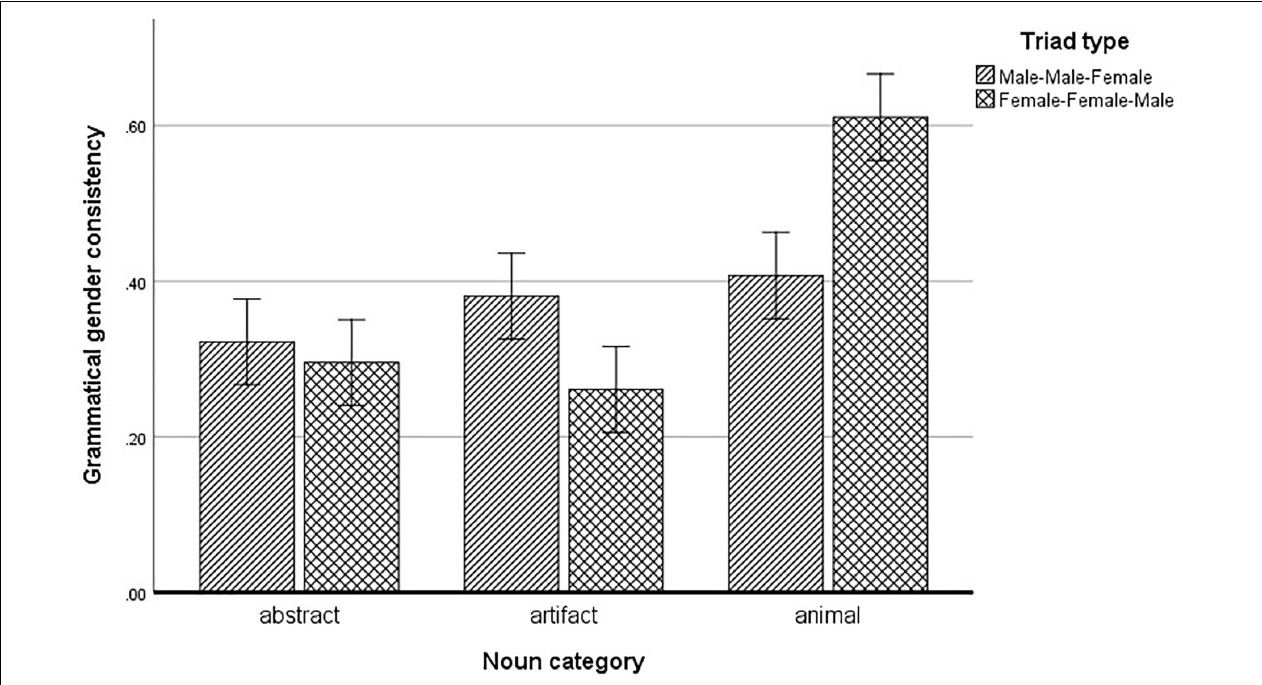
FIGURE 1 | Grammatical gender consistency across triad types and noun